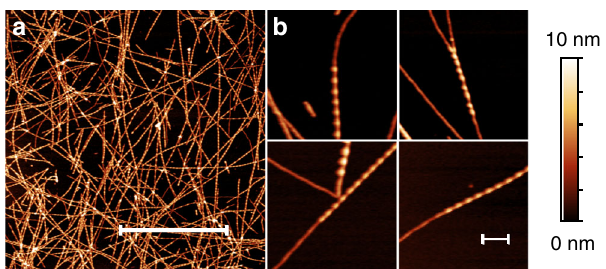
Fig. 2 AFM images of PI3K-SH3 amyloid fi brils. a AFM image of PI3K-SH3 fi brils (scale bar, 3 µ m). b Four different close-up views of fi brils showing both the thick, double fi lament (DF) fi bril and thin, single fi lament (SF) fi bril morphology (scale bar, 300